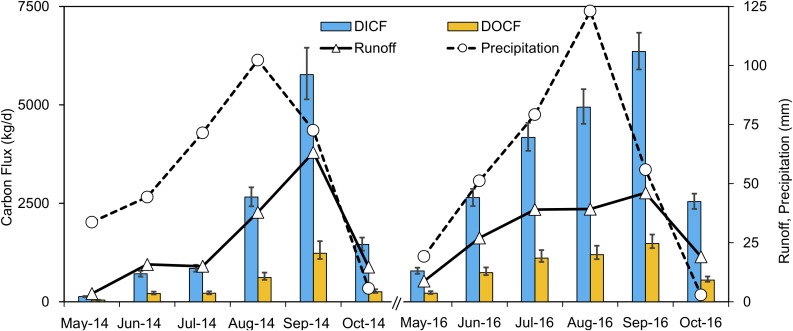
Monthly average DIC and DOC fluxes in kg/day, monthly total discharge, and precipitation variations of the entire watershed (Catchment 1) during 2014 and 2016.The error bars indicate the upper and lower 95% confidence intervals of LOADEST results.